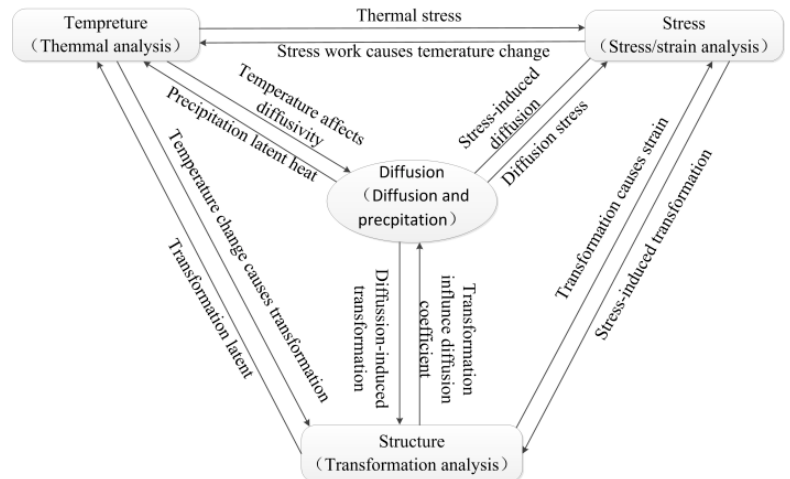
Figure 1. The schematic illustration of multi-field coupling theory.